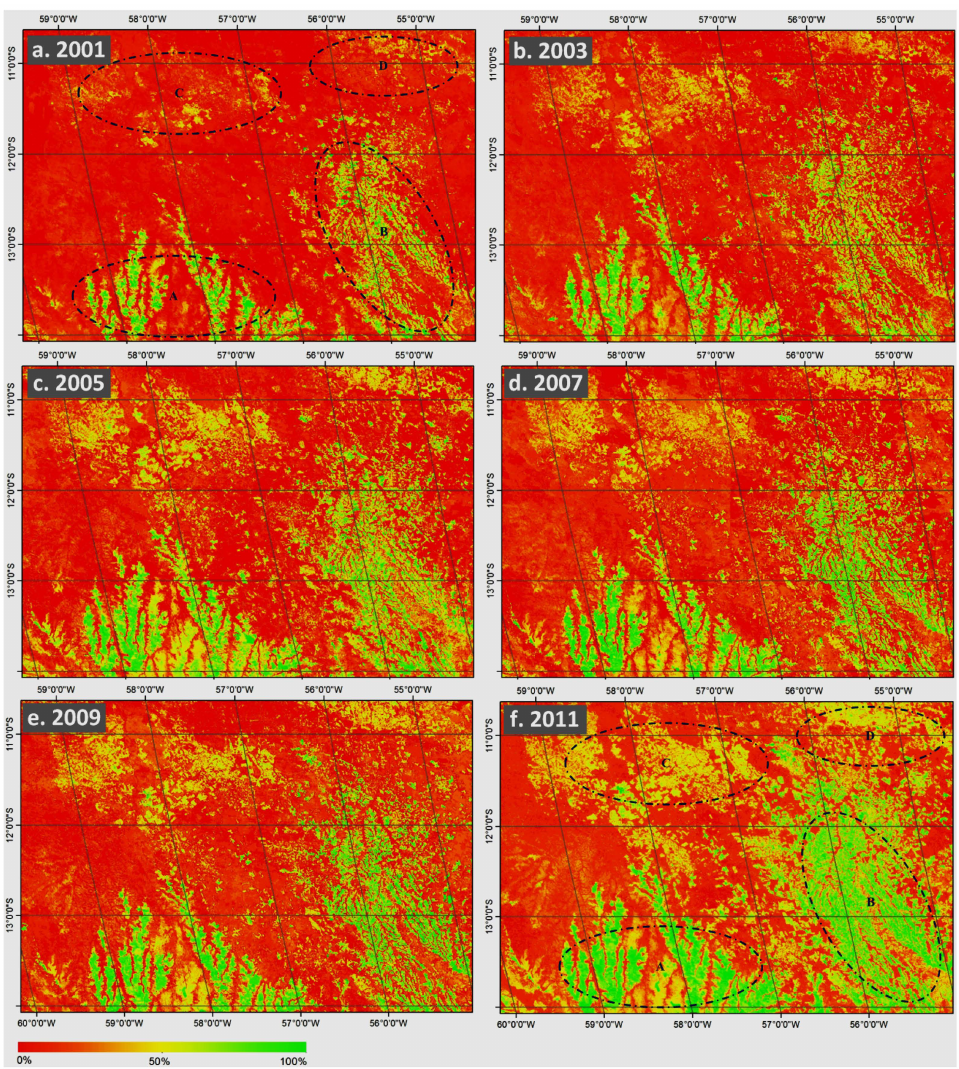
Figure 9. A comparison of the developed fractional cropland distributions between 2001 and 2011 at a two-year interval, which is developed using the SDI-based approach ( a – f represent the fractional cropland distribution in